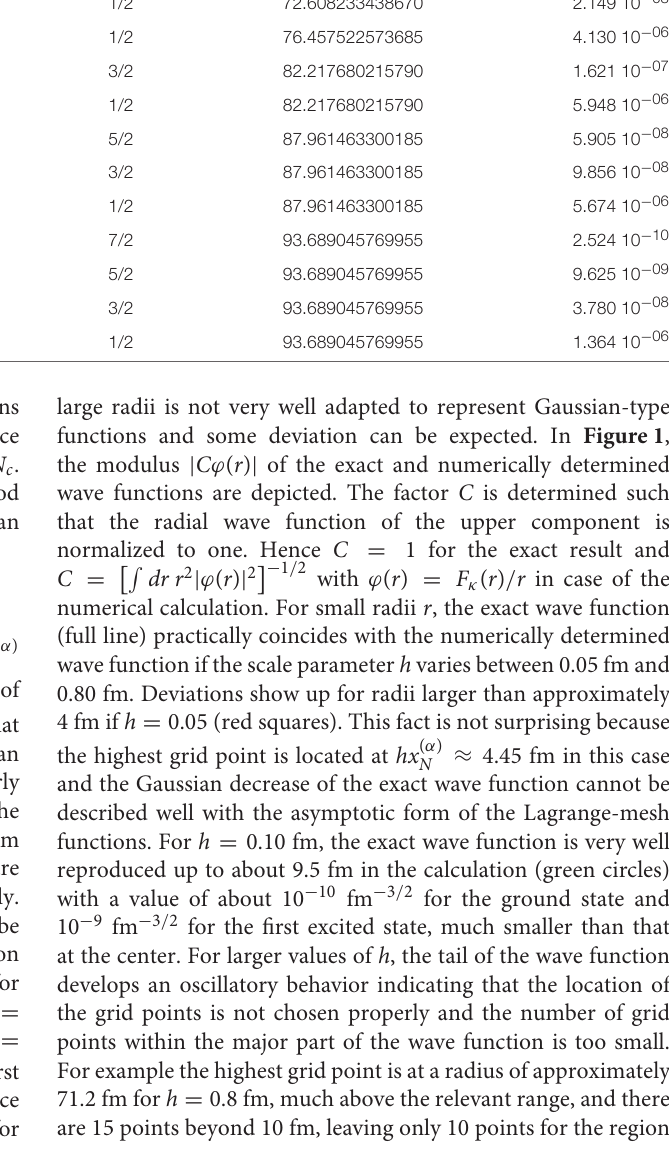
0.1 fm, number of grid points N =